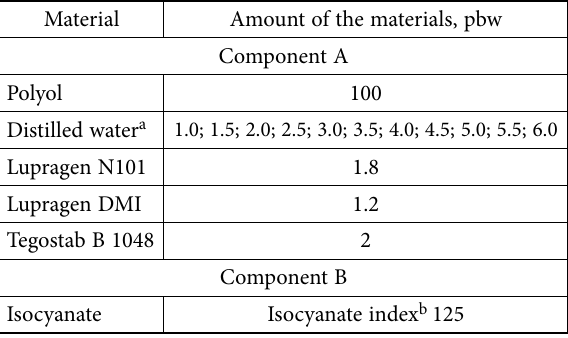
Table 1. Composition of polyurethane foams modified with different amounts of water